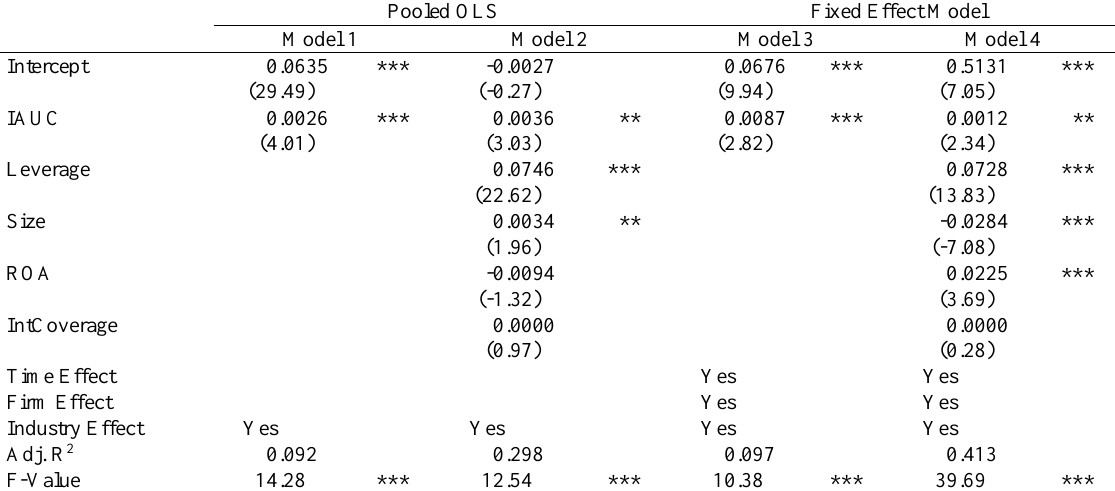
Table 9: Test results on hypothesis 1 for debt cost by using IAUC